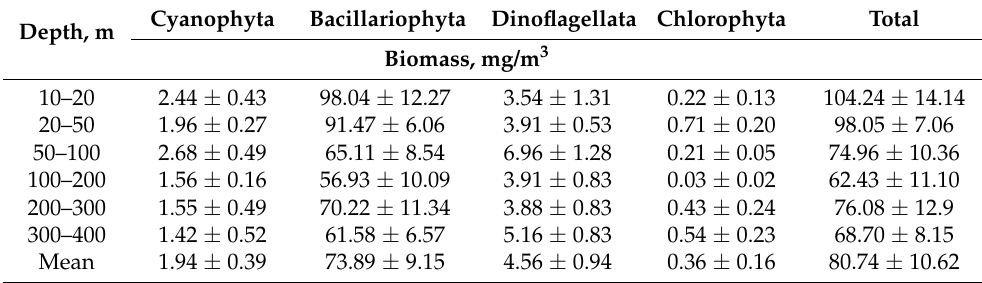
Table 3. Biomass of phytoplankton in the eastern part of the Middle Caspian (2014). Depth, m